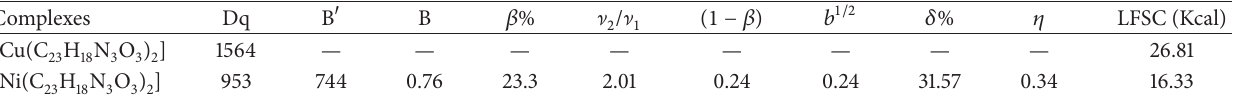
Table 2: Ligand field, Sinha, metal-ligand covalency percent, and covalency angular overlap parameters of Cu(II) and Ni(II) complexes. Complexes